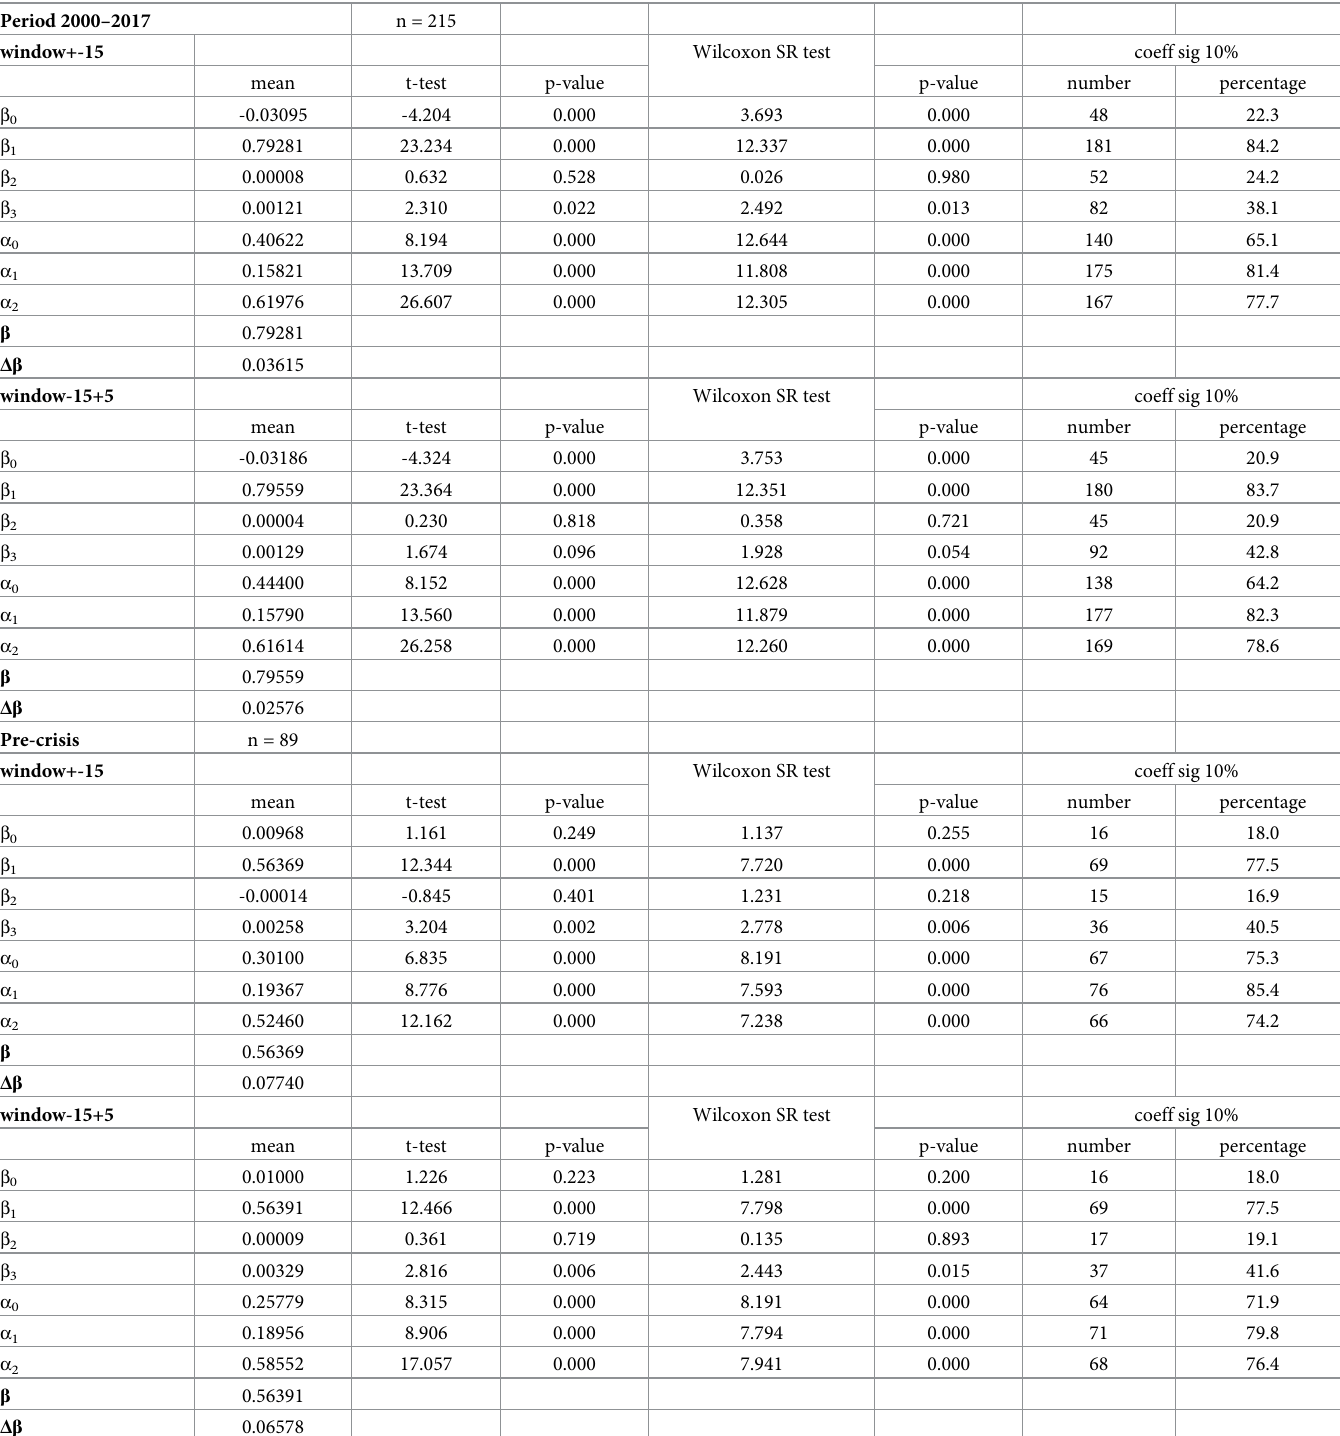
Table 11. Summary results: